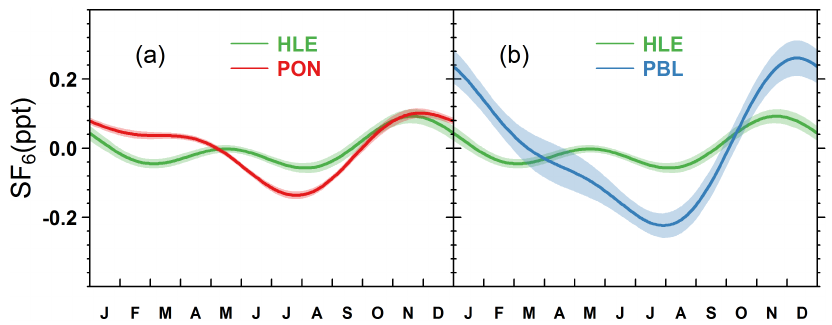
Figure 9. The mean SF 6 seasonal cycles observed at (a) HLE and PON and (b) HLE and PBL. For each station, the mean seasonal cycle is derived from the harmonics of the smoothed fitting curve in Fig. 8. Shaded area indicates the uncertainty of the mean seasonal cycle calculated from 1 SD of 1000 bootstrap replicates.